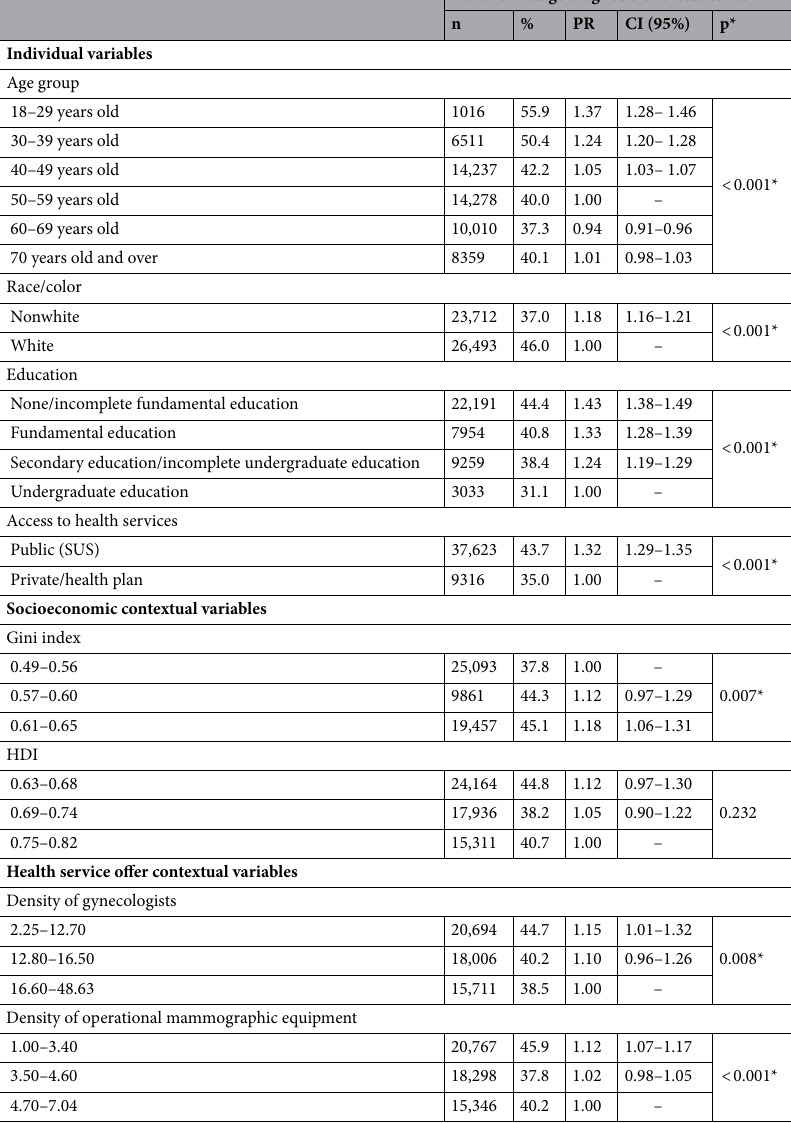
Table 1. Prevalence and non-adjusted prevalence ratios for advanced breast cancer staging, according to individual characteristics and contextual variables related to socioeconomic conditions and the offer of health services in Brazil, per FU, except São Paulo (n = 131,858). PR prevalence ratio adjusted by the multilevel model with random intercept, CI confidence interval, p Wald’s test. *Statistically